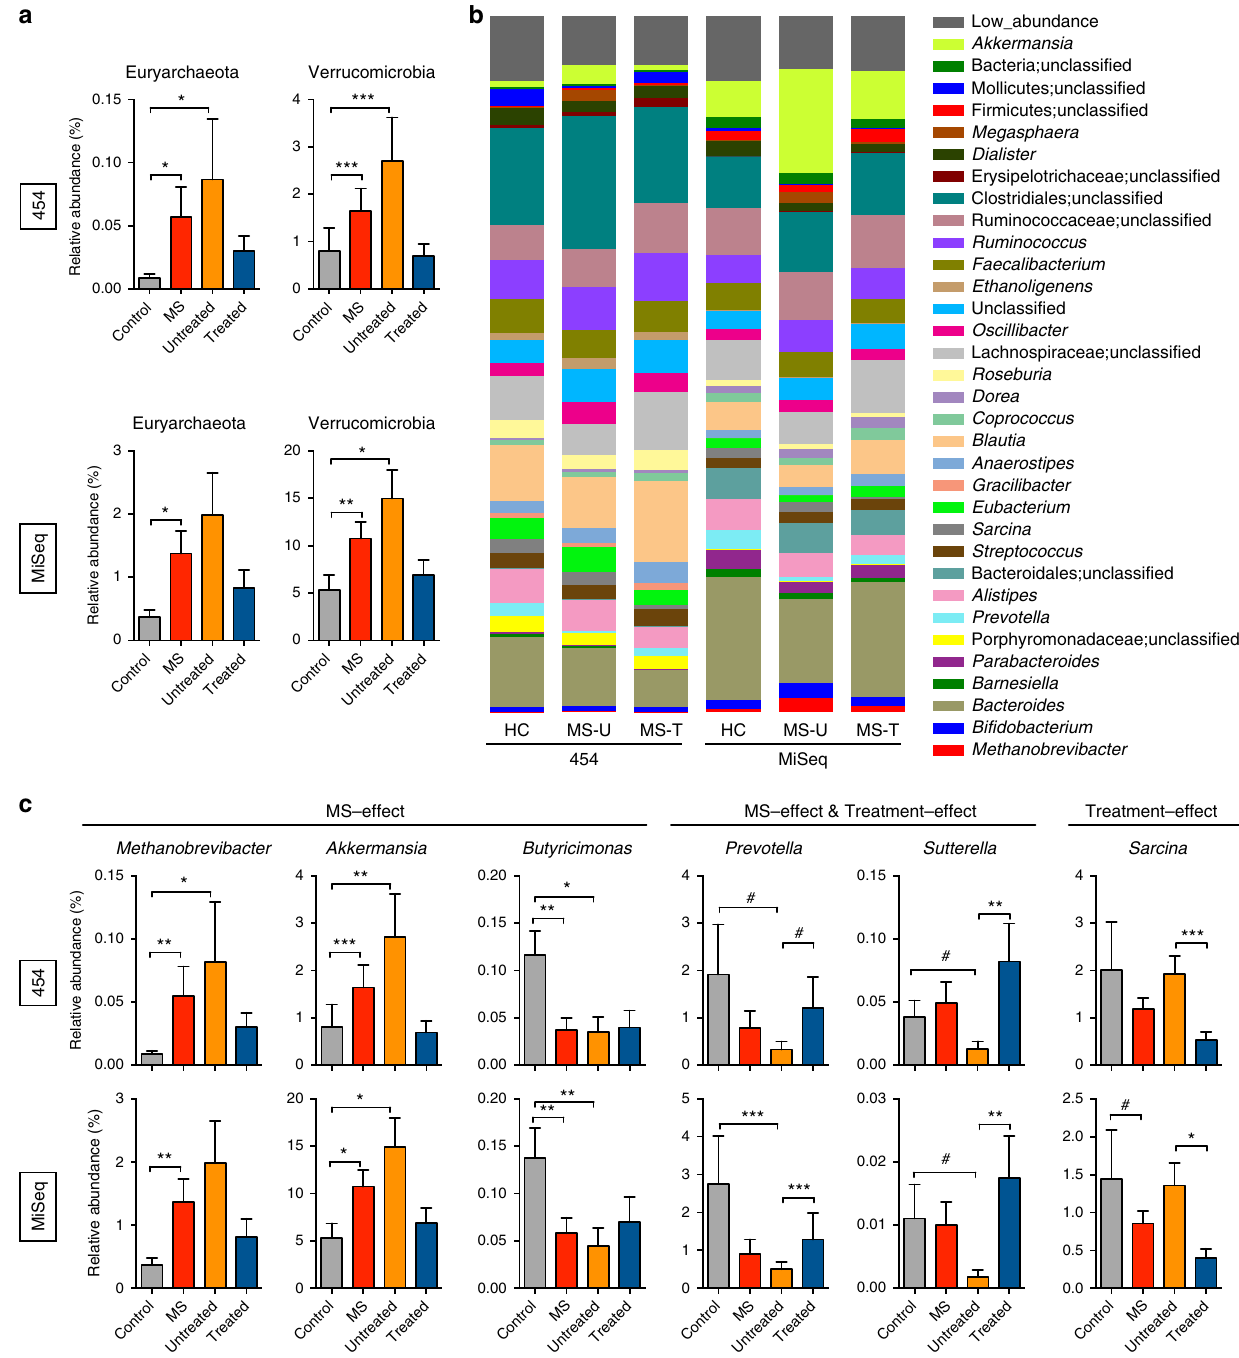
Figure 2 | Compositional differences in faecal microbiota between MS patients and healthy subjects. ( a ) Relative abundances of Euryarchaeota and Verrucomicrobia in the faecal microbiota of healthy controls ( n ¼ 43, grey bar), all MS patients ( n ¼ 60, red) and both untreated ( n ¼ 28, orange) and treated MS patient ( n ¼ 32, blue) subgroups as analysed by two independent sequencing technologies, 454 (top) or MiSeq (bottom). ( b ) Relative abundance of prevalent microbiota ( 4 1% in any sample group) determined from MiSeq and 454 high-throughput sequencing. ( c ) Relative abundances of genera in the faecal microbiota that are significantly altered between healthy controls ( n ¼ 43) and MS patients ( n ¼ 60; MS-effect) or between untreated ( n ¼ 28) and treated MS patients ( n ¼ 32) (disease effect) as analysed by two independent sequencing technologies. Significance was determined by DESeq and Benjamini–Hochberg corrected P values o 0.05 with a false discovery rate threshold of 0.1. Bars represent average, and error bars depict populations in untreated patients compared with controls, it suggests that treatment with immunomodulatory therapy may normalize some of the MS-related changes in the microbiota. The genus Sarcina was reduced in treated versus untreated MS patients by both sequencing platforms (Fig. 2b,c).